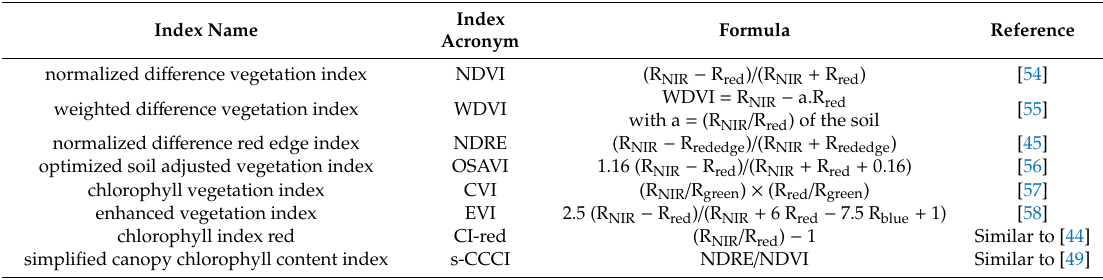
Table 2. List of the multispectral vegetation indices we have examined in this